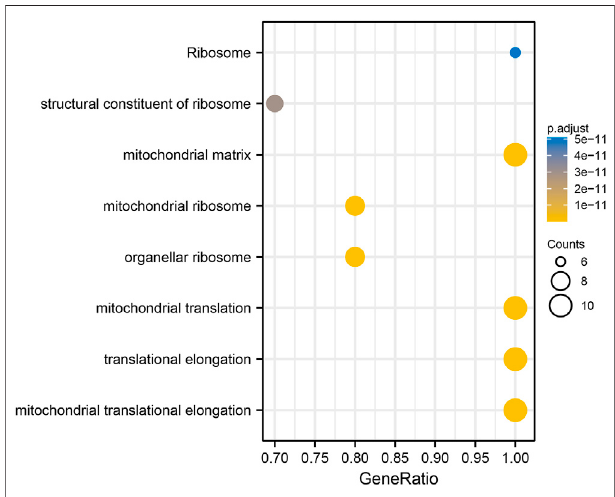
FIGURE 10 | Functional enrichment analysis of the top 10 hub genes.